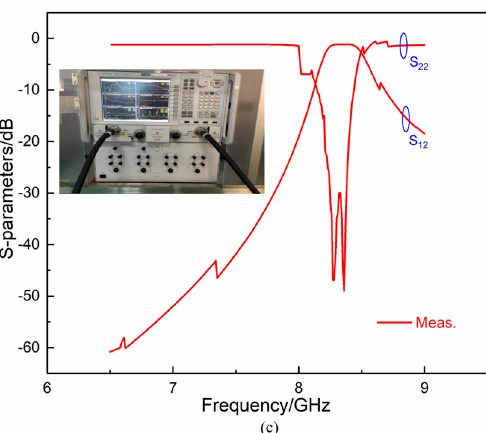
Figure 7. ( a ) Wideband responses of the S11 and S21 parameters. ( b ) Passband group delay. ( c ) Measured wideband responses of the S12 and S22 parameters. The inset shows the photograph of the network analyzer.